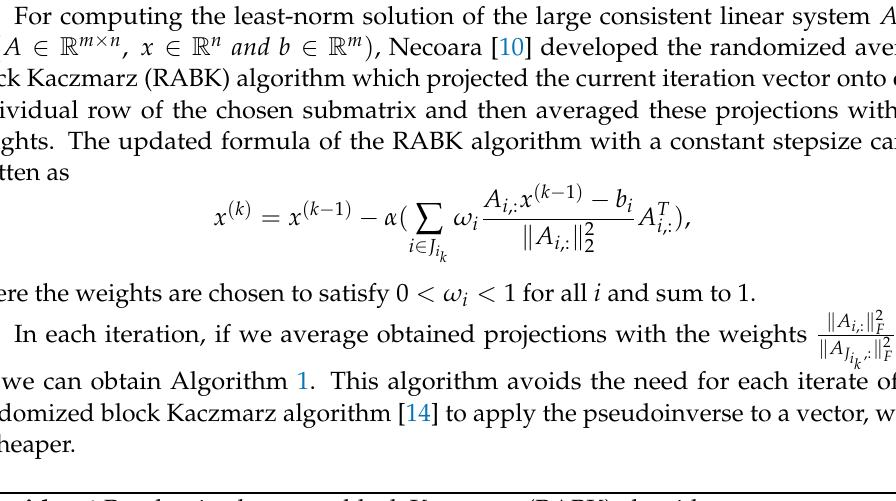
Algorithm 1 Randomized average block Kaczmarz (RABK)